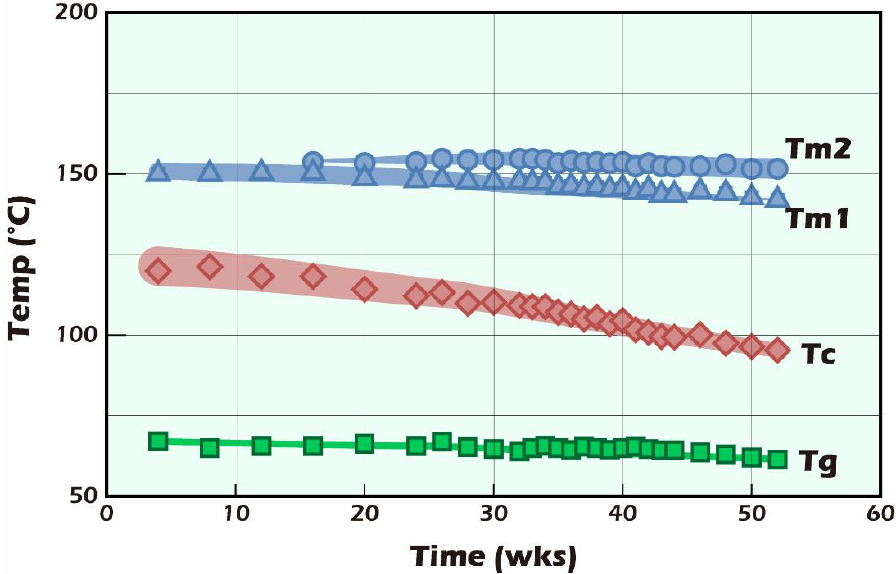
Figure 12. The variety of partially crystalline PLLA samples in the temperature of glassification (Tg), crystallization (Tc), and melting (Tm) after hydrolysis in PBS for 1 – 52 weeks.